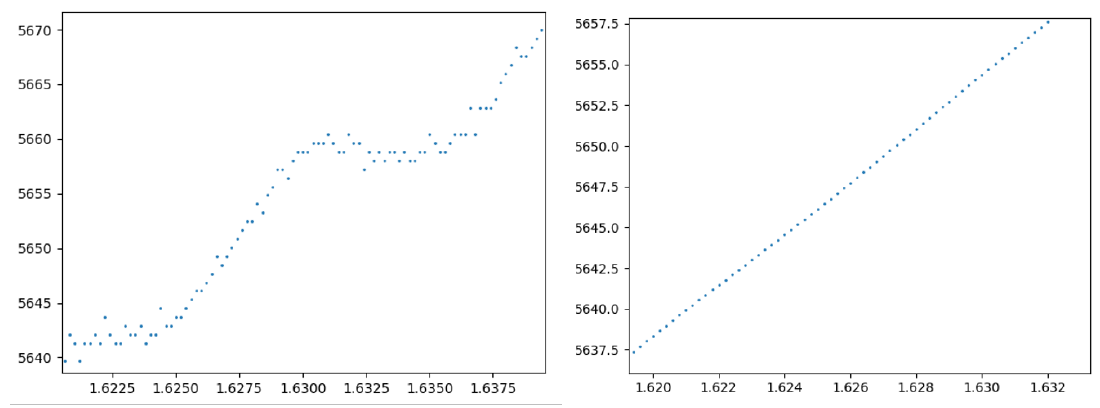
Figure 9. Raw data ( left ) and the result ( right ) after the smoothing